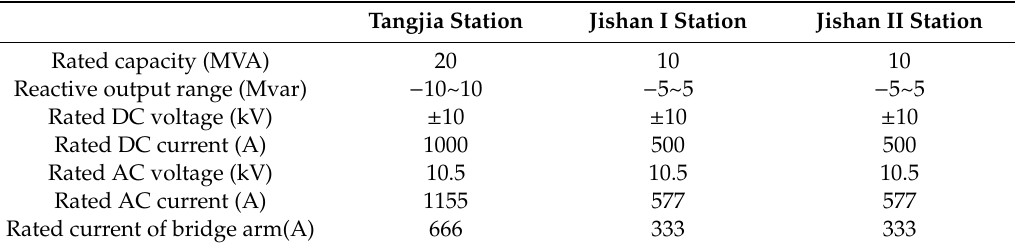
Table 1. Parameters of the converter.